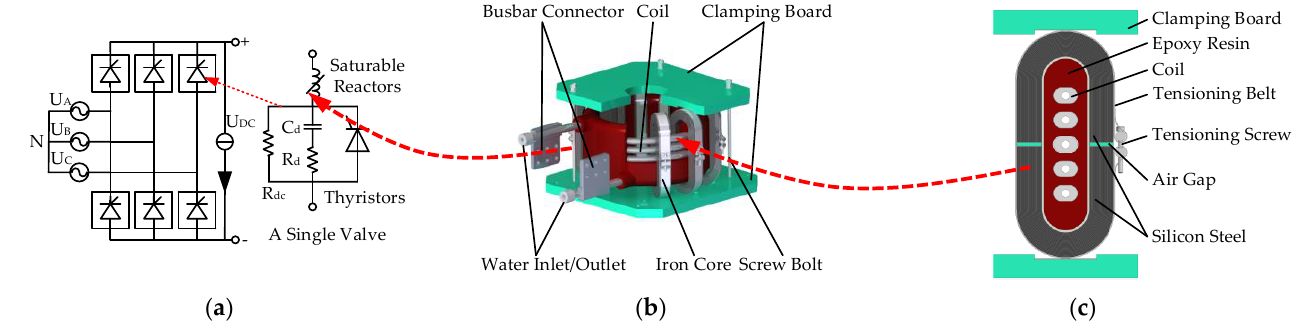
Figure 1. Structure of the UHVDC thyristor valve and saturable reactor: ( a ) UHVDC thyristor valve appearance; ( b ) saturable reactor structure; ( c ) iron core cross-sectional view.